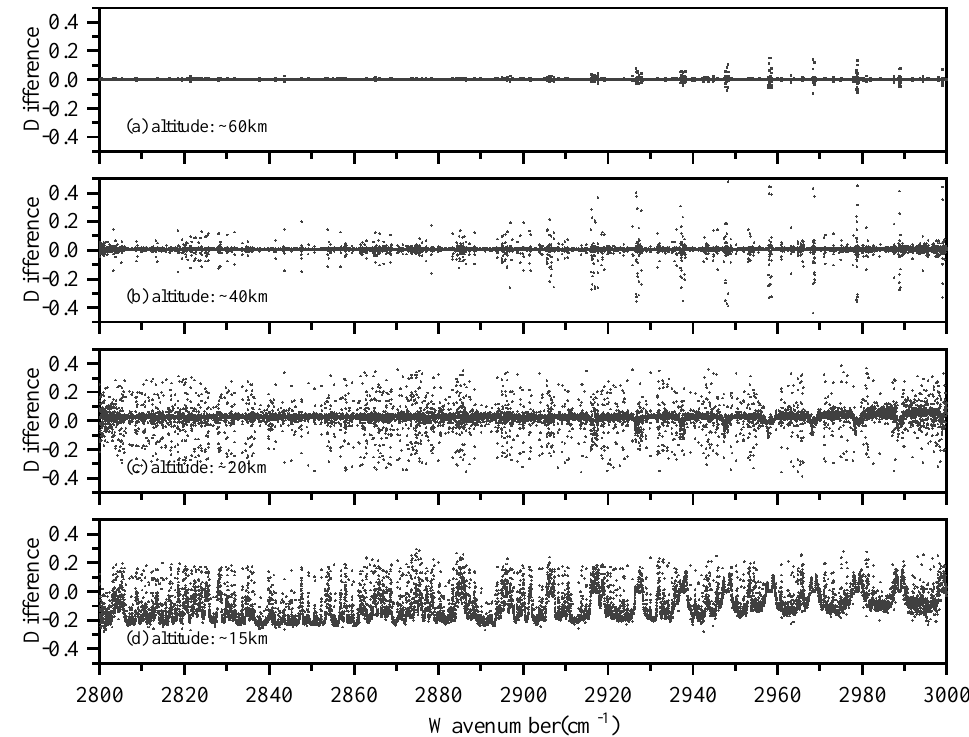
Figure A8. The transmittance differences between AIUS measurements and simulations in 2800–3000 cm − 1